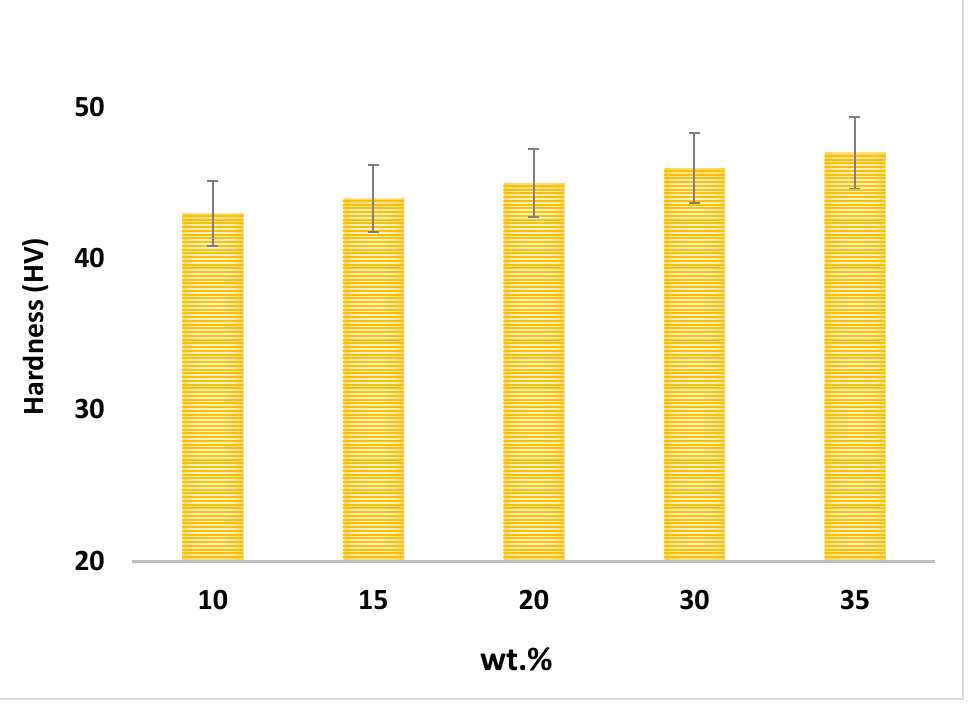
Figure 11. Vickers hardness values for different weight percentages of Fe 3 O 4 in the composites.